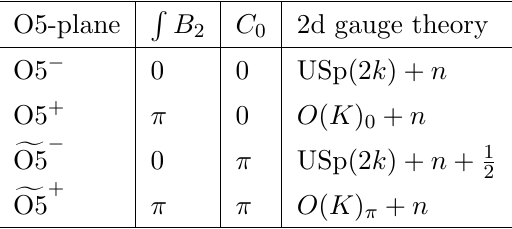
(cid:6) = 0 or C = (cid:25) . For O5 (cid:6) C = 0, and for f O5 C 0 = (cid:25) . Thus 0 0 0